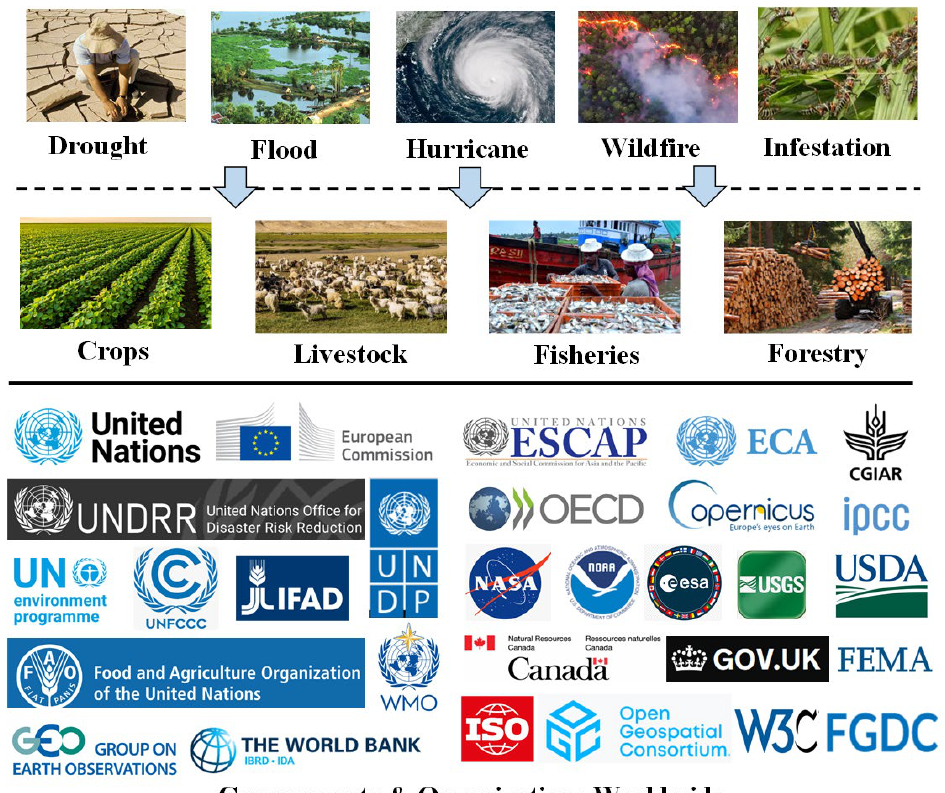
Figure 1. The major players worldwide.